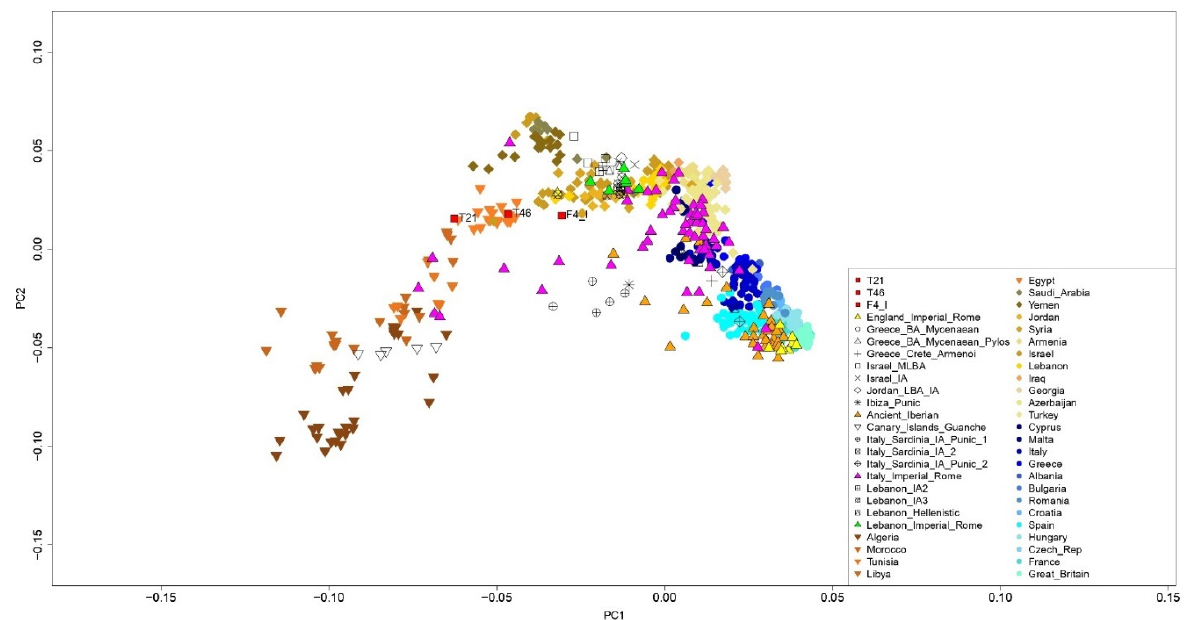
Figure 2. Principal component analysis (PCA) plot for the visualization of CB samples (labeled as red squares) and individuals from the Supplementary Table S1, using the “shrinkmode: YES” option.